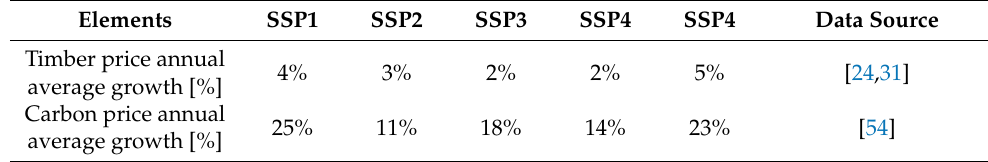
Table A1. Timber price and carbon price changes across SSPs.